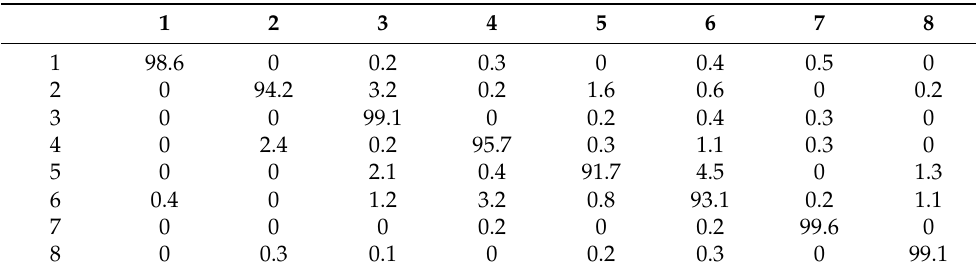
Table 2. The recognition accuracy (in %) of the financial operation type using tf-idf values. In this table, 1 means shareholder operations, 2—operations with salaries, 3—return operations, 4—other operations, 5—other financial operations, 6—residual operations, 7—depreciation oper- ations, 8—sales operations.